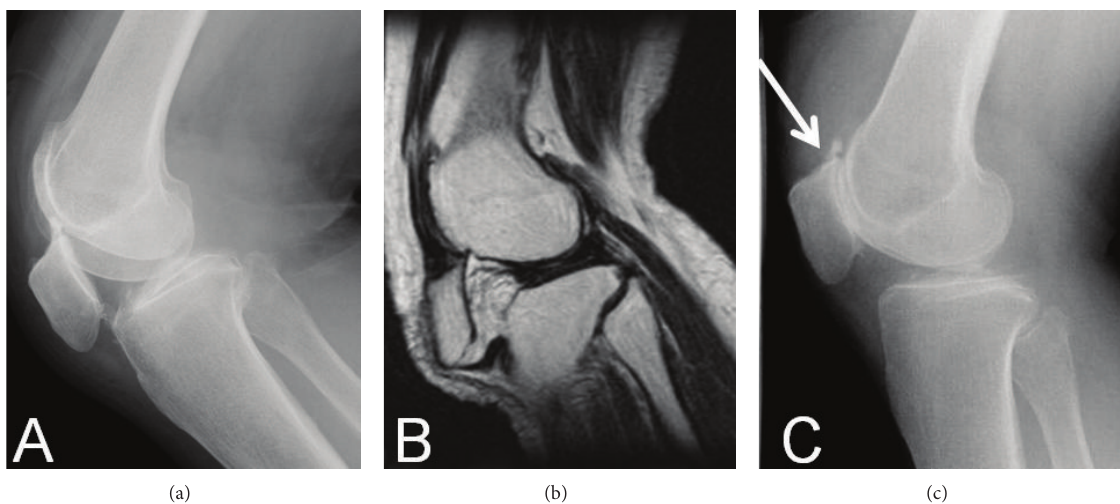
Figure 3: (a) Plain lateral radiography: the patella is dislocated inferiorly. (b) MRI: the osteophyte on the superior pole of the patella has become impacted in the femoral trochlea. (c) Plain radiography after manual reduction: the osteophyte on the superior pole of the patella is completely fractured